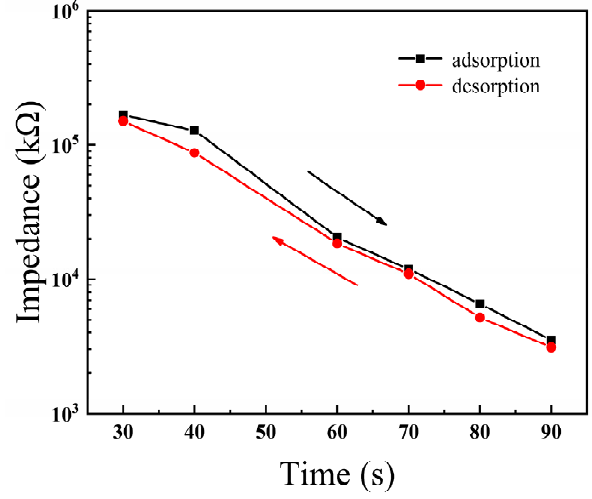
Figure 5. Humidity hysteresis characteristics of BiFeO 3 film measured at 10 Hz.